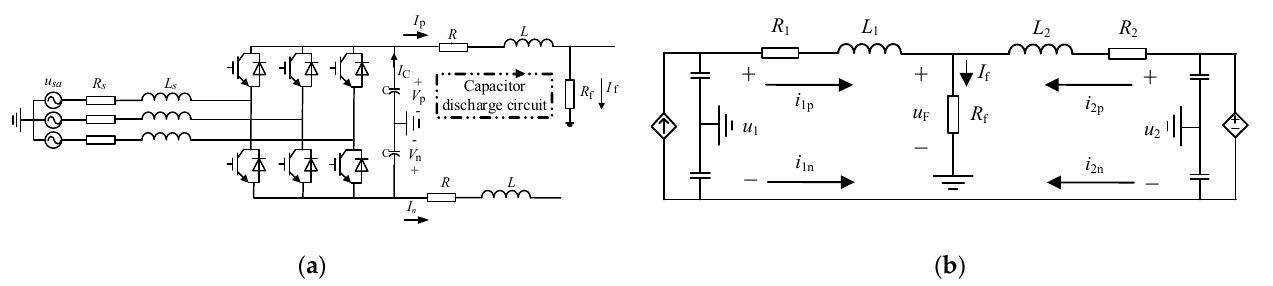
Figure 1. Schematic diagram of the capacitor discharge stage during high resistance fault. ( a ) capacitor discharge stage circuit; ( b ) equivalent diagram.